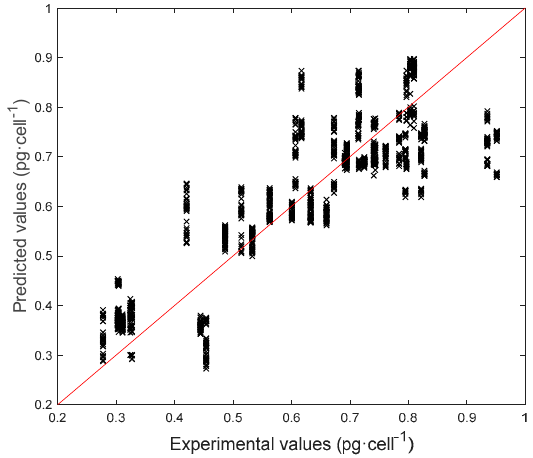
Figure 14. Parity plot for model P[ 𝐗 𝐂𝐈 |𝐗 𝐂𝐱 ‖ Chla], SSR = 33.76. Table 4. Performance of the models used to estimate Chl a